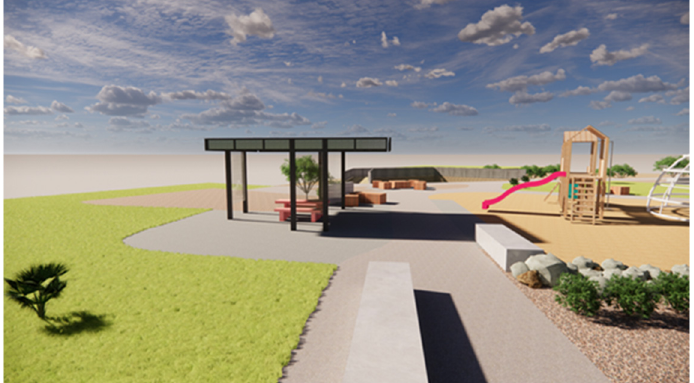
Figure 6. Shade structure at Baldivis One71 Pump Track.